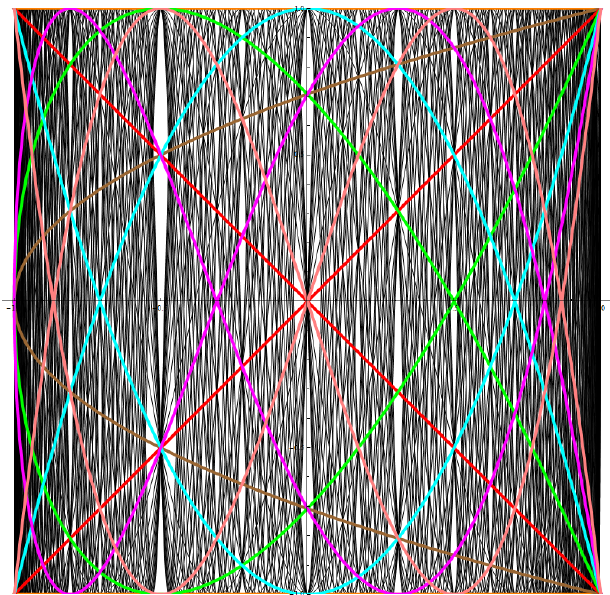
Figure 2. The first seven white curves, each in different colour.